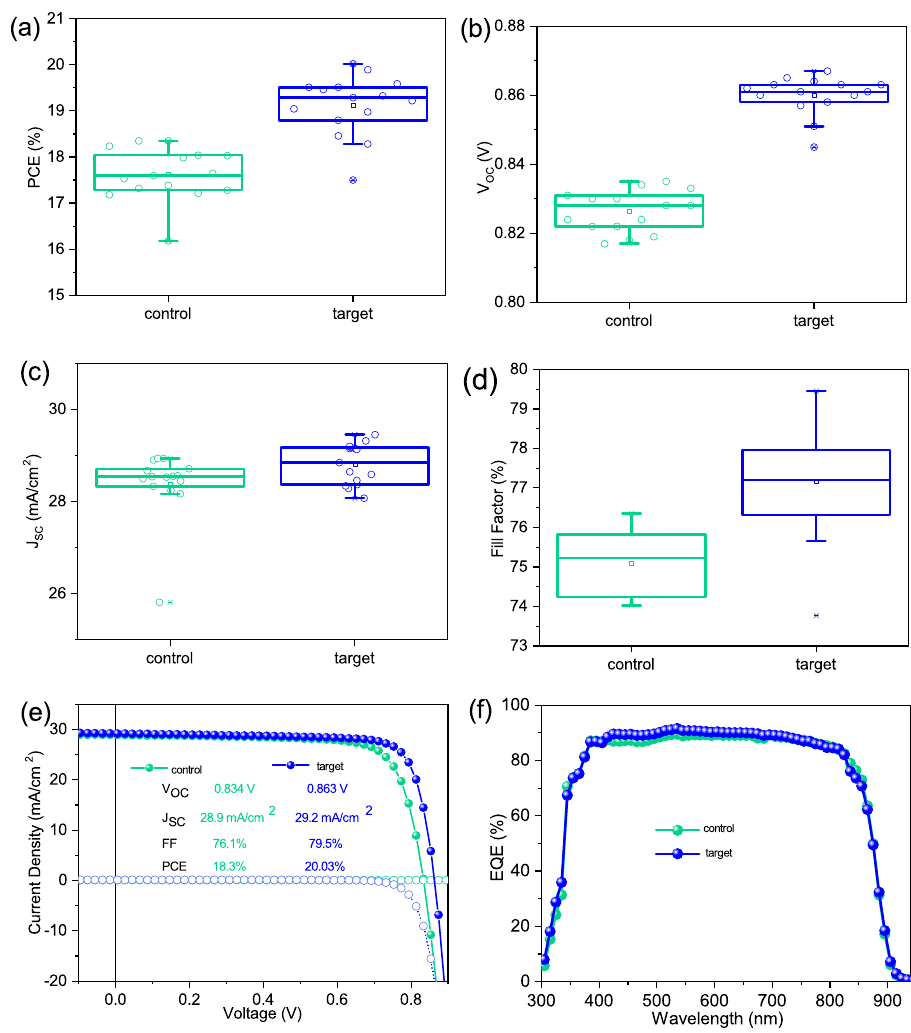
Fig. 4 | Performance improvement of devices with the Cd(O,S,Se,Te) region. a – d ThestatisticaldistributionofthePVparameters(centrelinesshowthemedian, boxes show the upper and lower quartiles, and the whiskers show the full range; each blackand red circle inthe boxand whisker plots presents the value of the J – V